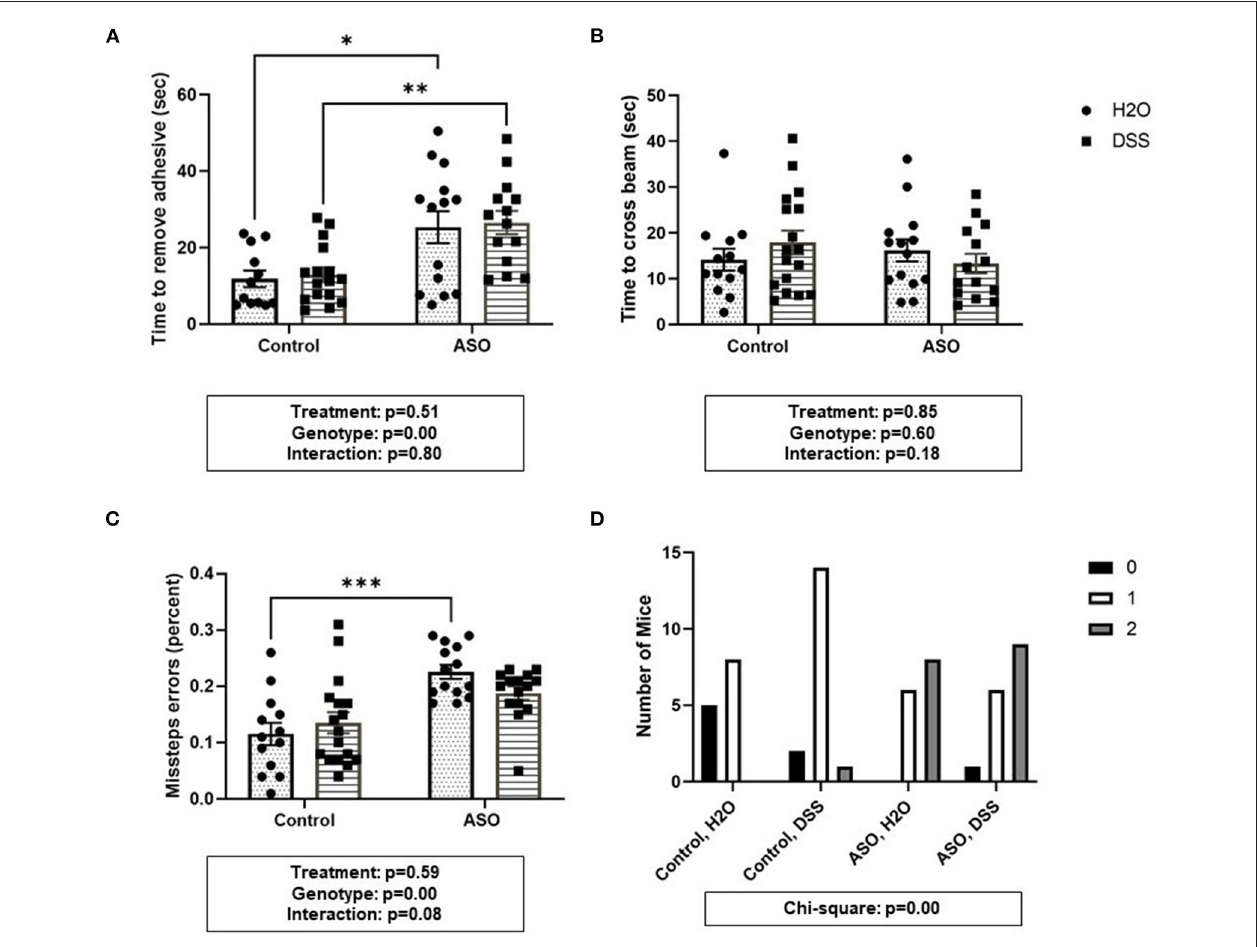
FIGURE 5 | Parkinsonian behavioral analysis in control and ASO mice. Motor function was evaluated using four behaviors. (A) Adhesive removal: ASO mice significantly took longer to remove the adhesive from the bridge of the nose than WT mice. (B) Beam traverse: There was no difference in the time to cross the beam between WT and ASO mice. (C) ASO mice had significantly more missteps off the beam than WT mice. (D) Hindlimb Clasp Reflex Score: ASO mice had significantly worse hindlimb clasp than WT littermates. Outliers were omitted prior to analysis ( > 2 standard deviations from the mean). Two-way ANOVA was conducted and values for different factors are indicated in the graphs followed by post-hoc Tukey which is indicated on each graph when appropriate * p < 0.05, ** p < 0.01, *** p < 0.001. (D) Chi-square analysis. ASO, α -synuclein overexpressing; H 2 O, water; DSS, dextran sodium